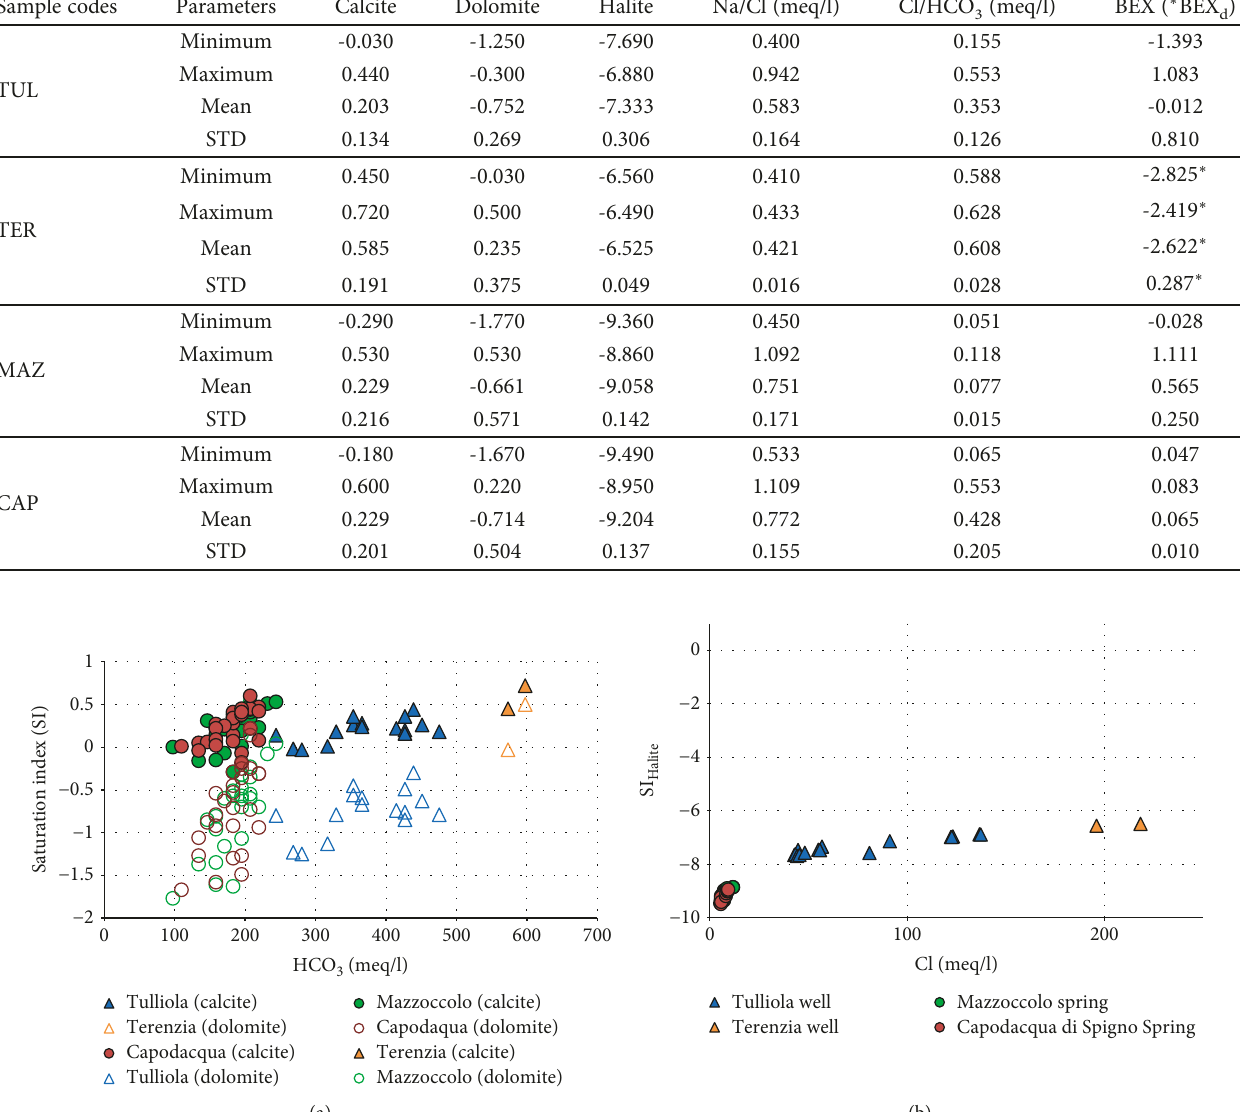
Table 4: Statistical summary of saturation indices of minerals in groundwater using PHREEQC. BEX index and some ionic ratios of interest in the study area.